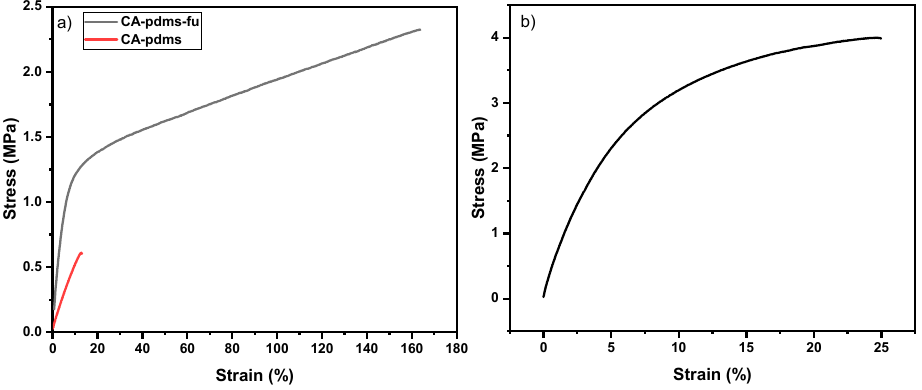
Figure 7. Stress-strain curve of ( a ) CA-pdms (red curve), and CA-pdms-fu (black curve), and ( b ) poly(CA-pdms-fu) films.